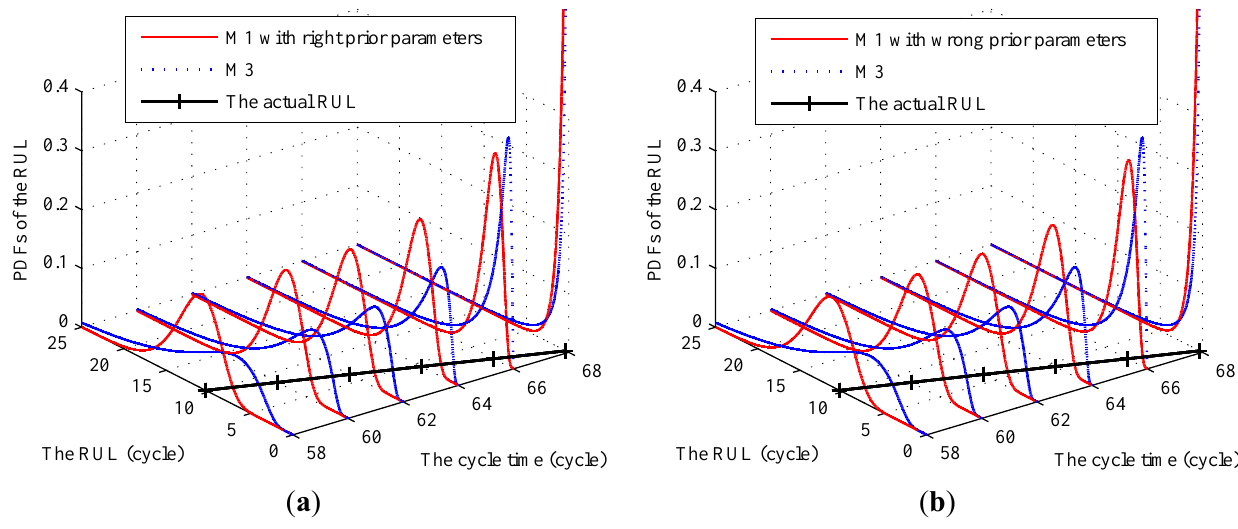
Figure 9. The estimated PDFs of the RULs by M ( b ) inappropriate prior